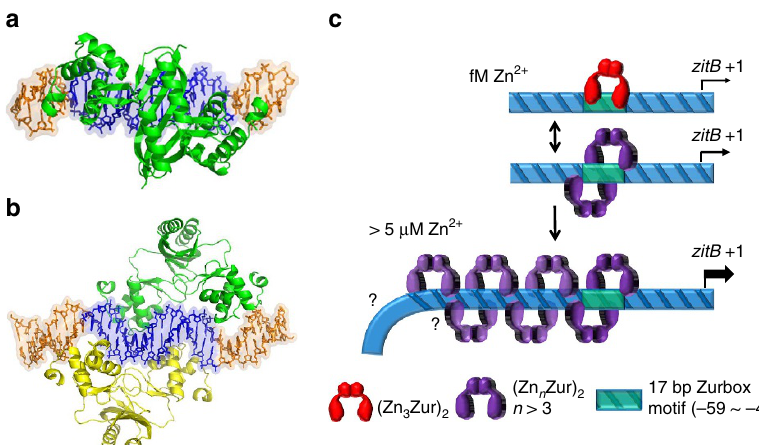
Figure 6 | A scheme for zinc-dependent changes in the binding mode of Zur on zitB DNA. A structural model for the Zur 2 -DNA (25bp) complex ( a ) and a model for Zur 4 -DNA (33bp) complex ( b ). The blue regions in DNA represent the 15bp Zur-box motif. The two figures were prepared with the same DNA orientation, to show the distinct binding modes of dimeric versus tetrameric Zur. ( c ) A schematic model for the change in the binding mode of Zur on zitB promoter region as zinc level increases. The dimeric Zur with three high-affinity zinc-binding sites occupied by zinc at femtomolar range (Zn 3 Zur) 2 was indicated in red, whereas the oligomers of dimeric Zur with possibly more zinc binding at low-affinity site(s) were presented in